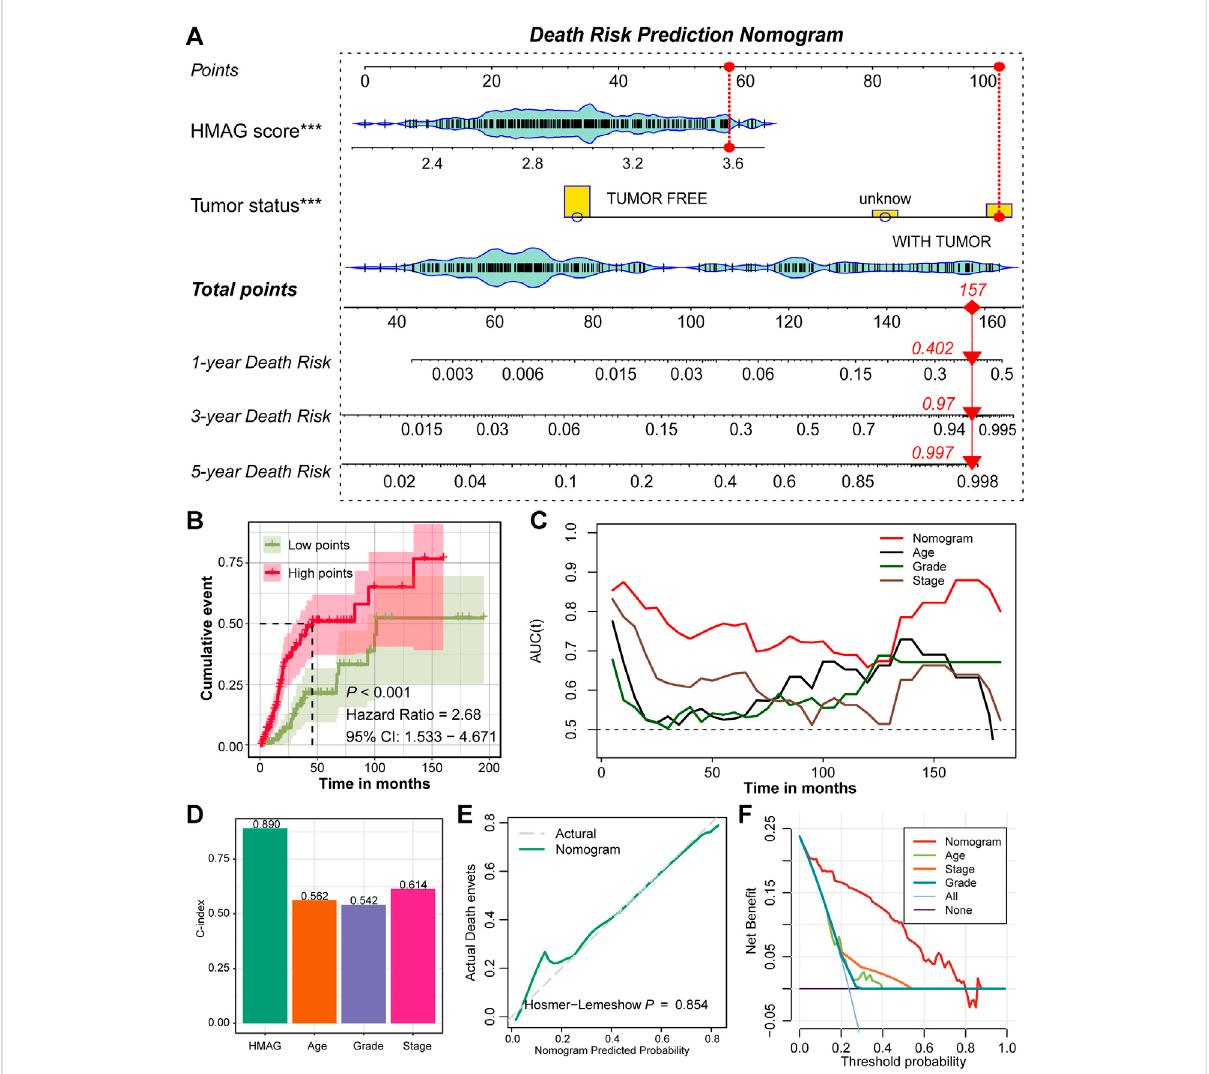
FIGURE 5 Prognostic nomogram constructed by the HMAG signature and tumor status. (A) Establishment of a nomogram combining the tumor status and HMAG signature; (B) K-M plot showing the diverse cumulative death event in low points and high points subgroups; (C) time ROC lines showing the prognostic value of nomogram, age, grade, and tumor stage; (D) bar plots showing the C-index of nomogram, age, grade, and tumor stage; (E) calibration plot for the nomogram. The dashed line represents the ideal nomogram, the solid line represents our nomogram, and a p -value of 0.854 indicates that the nomogram-predicted probability is very close to the actual death events; (F) DCA showed that our nomogram had the greatest net bene fi t compared with the single factor of age, stage, or